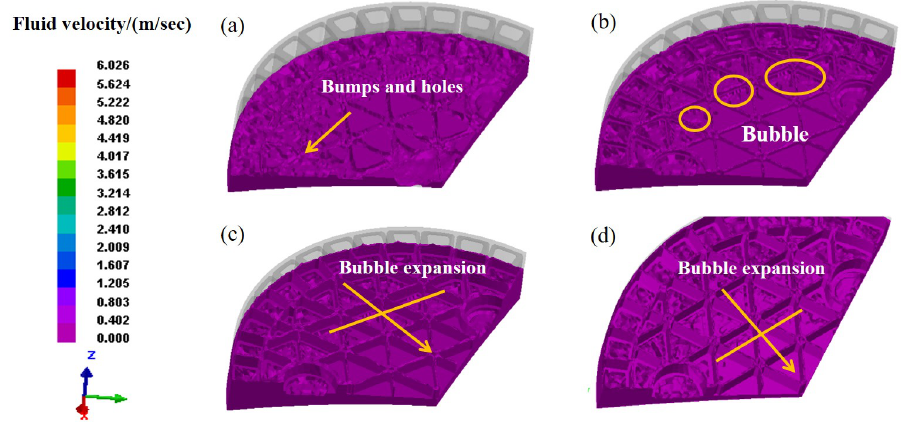
Figure 8. Fluid velocity contours in filling process. ( a ) 33.12 s, ( b ) 34.24 s, ( c ) 35.01 s, ( d ) 36.92